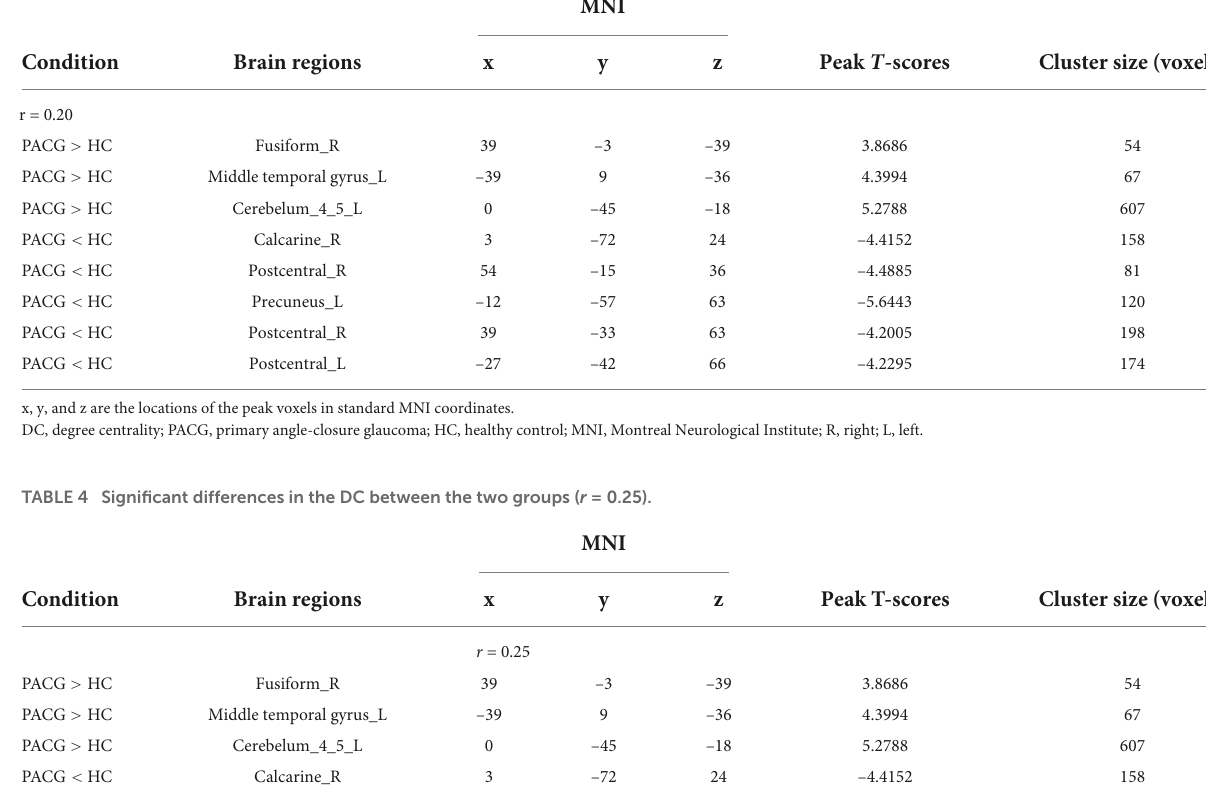
TABLE 3 Significant differences in the DC between the two groups ( r = 0.20).